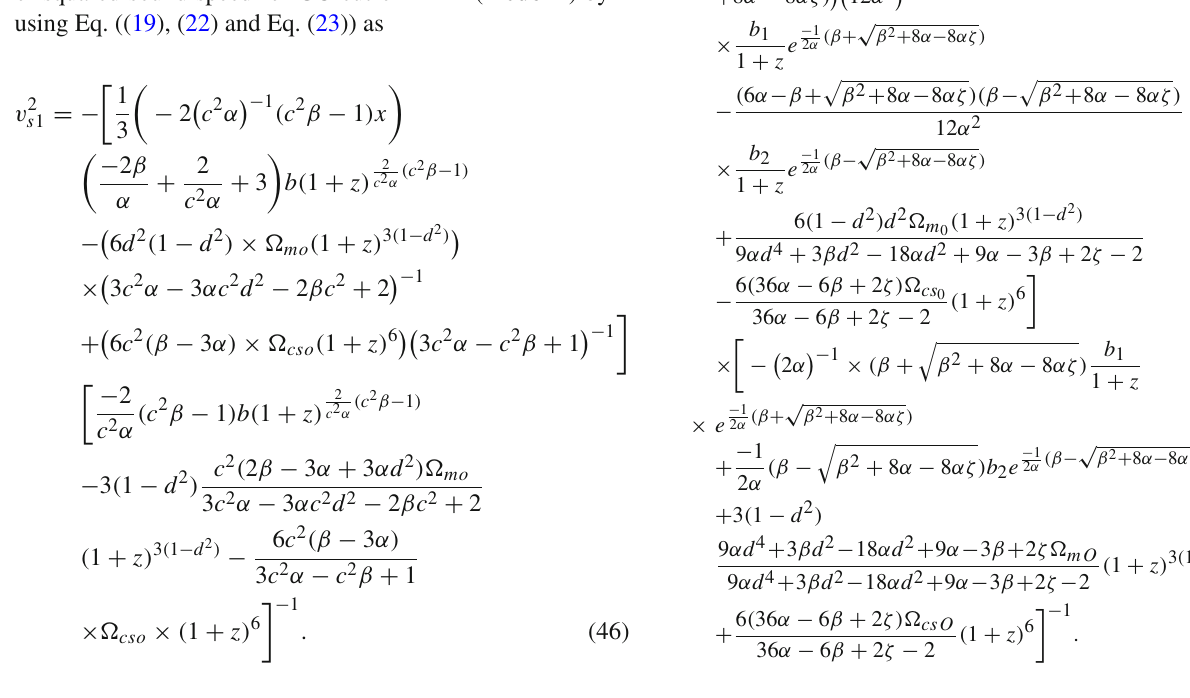
For model 2 , the equation of squared speed of sound